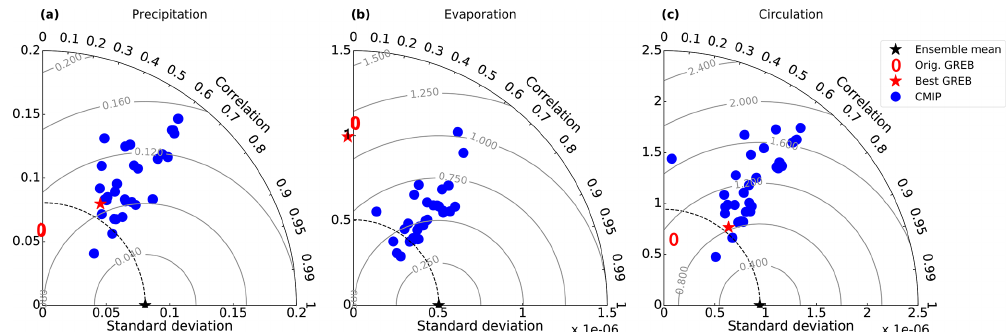
Figure 12. RCP8.5 response of CMIP5 models (blue), original GREB (0) and improved GREB (red (cid:70) ) per degree of global warming against the CMIP5 ensemble mean (black star). Precipitation (a) , evaporation (b) and circulation (c) are shown. GREB uses prescribed anomalies from the CMIP5 ensemble mean of surface temperature, horizontal winds and vertical winds ( ω ). The correlation of the original GREB model precipitation response with the ensemble mean is zero. The original and improved GREB models have zero correlation with the ensemble mean evaporation and the standard deviation is 1 for